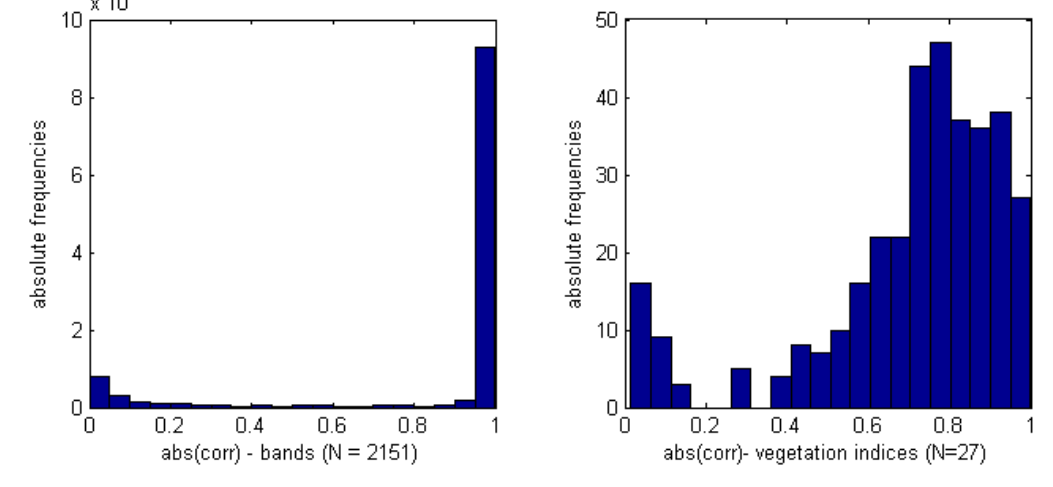
Figure 4. Histogram of the absolute values of pairwise correlation between individual bands (left) and vegetation indices (right) that are listed in Table 1. N indicates the number of spectral bands or vegetation indices considered. The total number of pairs can be calculated as N * (N − 1) /2